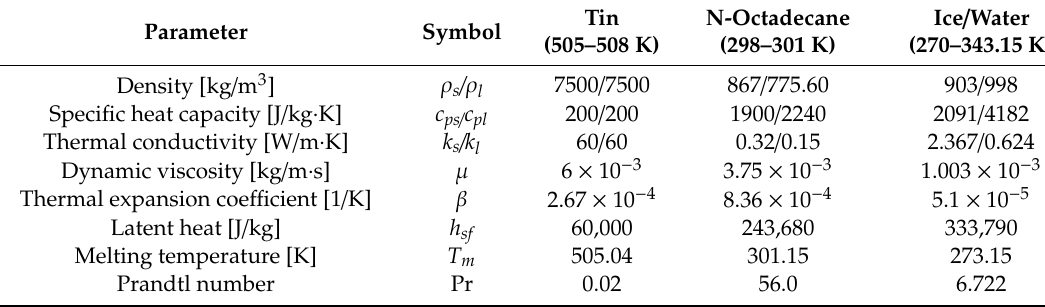
Table 1. Thermophysical properties of pure tin [35], n-octadecane [36], and ice